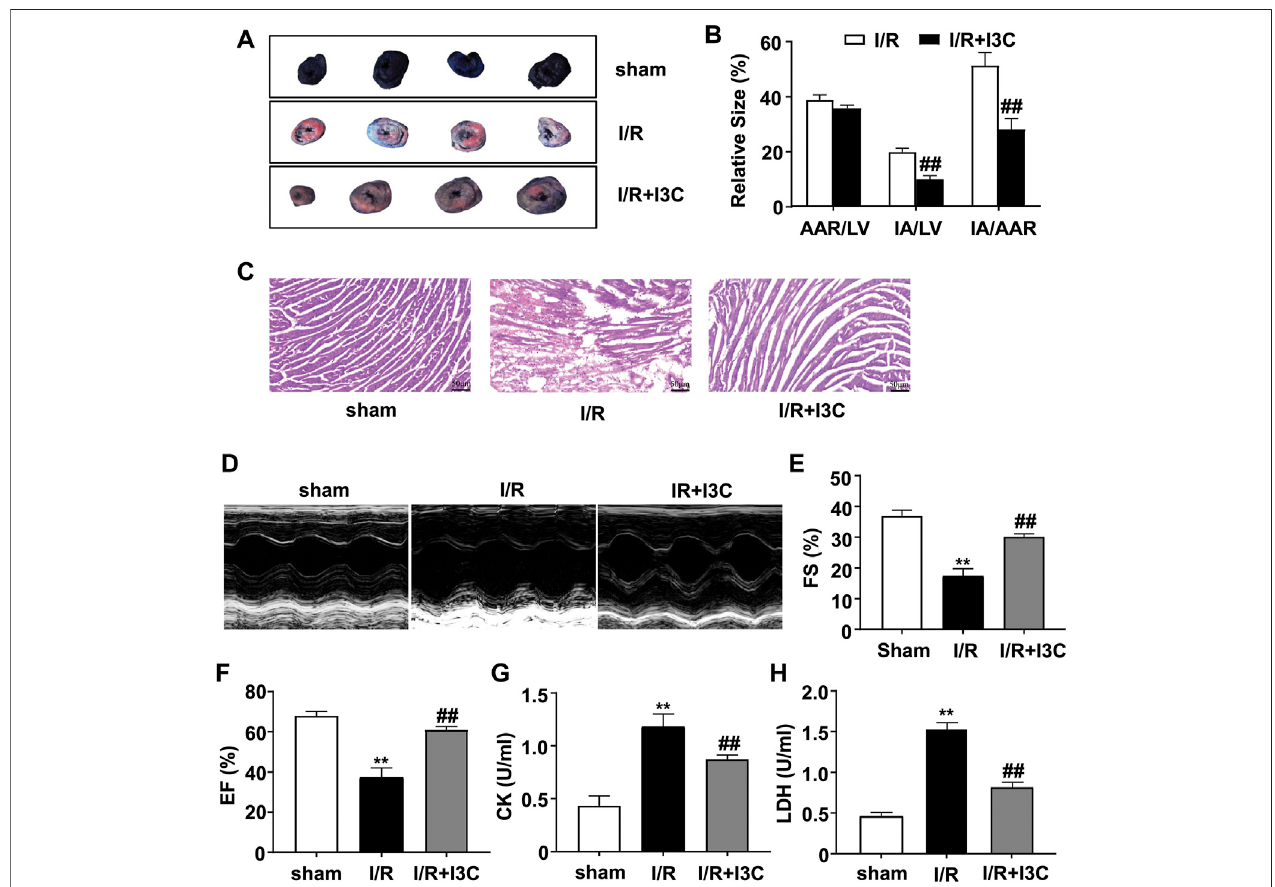
FIGURE 1 | Effect of I3C on I/R-induced myocardial injury and cardiac function. (A) A representative photograph shows Evans blue/TTC double-staining in the heart of mice treated with or without I3C (100 mg/kg). The nonischemic area, which was not at risk, was stained blue, whereas the area at risk was red and the infarct area was pale. (B) Quantitative analysis showed infarct size of the heart 24 h after reperfusion in mice treated with or without I3C: I3C pretreatment reduced IA/LV in I/R mice from 19.73 to 9.90% and IA/AAR in I/R mice from 51.19 to 27.91% (n = 5, ## p < 0.01 vs. I/R); AAR, area at risk; LV, left ventricle; IA, infarct area. (C) Representative hematoxylin-eosin (HE) staining results showed I3C pretreatment reduced I/R-induced cardiac injury in mice. Scale bar: 50 μ m. (D) Representative images show cardiac function determined by echocardiography. (E,F) Quantitative analysis showed that I3C pretreatment prevented the I/R-induced decrease in fractional shortening (FS, (E) ) and ejection fraction (EF, (F) ) values (n = 5, ** p < 0.01 vs. sham treatment, ## p < 0.01 vs. I/R). (G,H) Quantitative analysis showed that I3C pretreatmentpreventedtheI/R-induced increaseinserumlevelsofcreatinekinase(CK, (G) )andlactatedehydrogenase(LDH, (H) )( n =5,** p < 0.01vs.shamtreatment, ## p < 0.01 vs. I/R). Data are expressed as mean ±